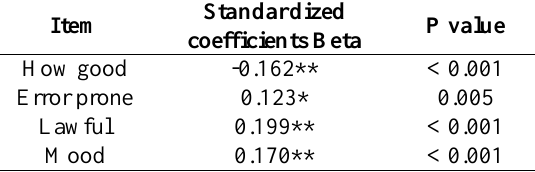
Table 7. Predictors of factor 2